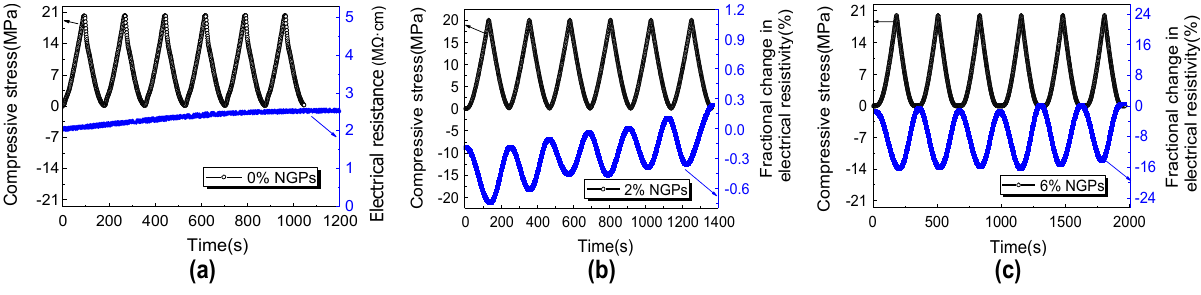
Figure 5. Effect of NGPs dosage on the fractional change in resistivity under compressive loading: ( a ) without NGPs; ( b ) with 2% NGPs; ( c ) with 6% NGPs [73].